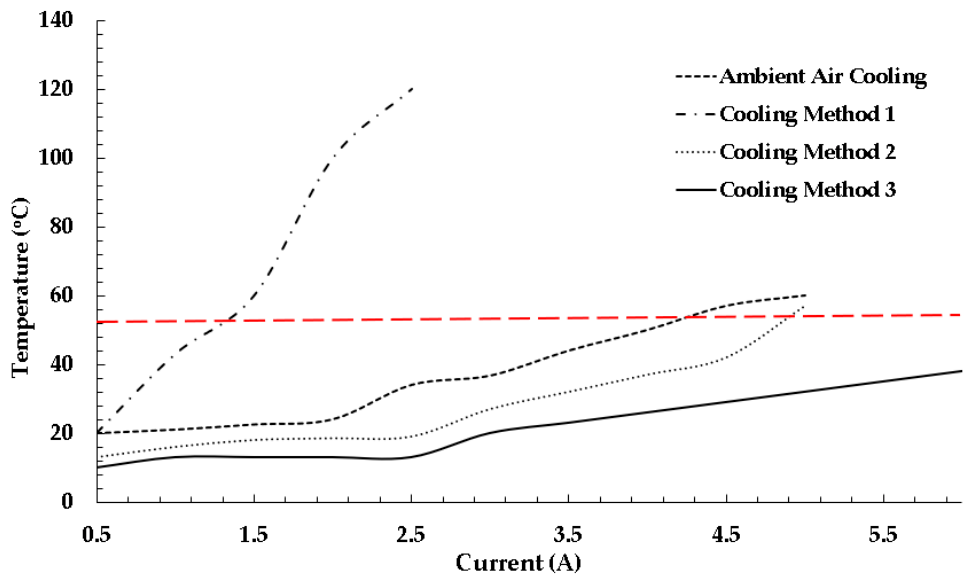
Figure 11. Averaged steady-state temperature for each current setting. Ambient air cooling is without